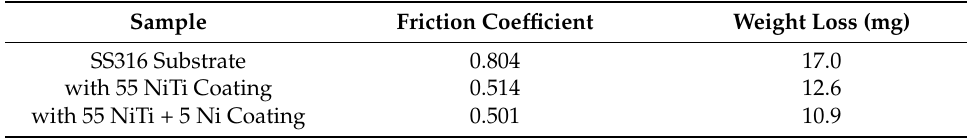
Table 5. Result of friction coefficient and wear mass